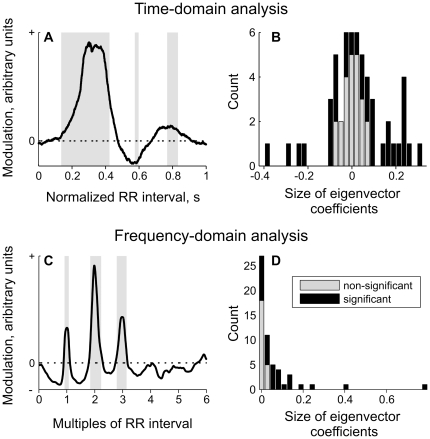
Principal component analysis (PCA) of 55 spontaneously active afferents in control (resting) conditions.Top panels display the first principal component of the time-domain analysis (explained variance = 48%), i.e. R-wave triggered discharge rate averages, extracting the modulation pattern common across afferents. Panel A shows the projection of the data with characteristic regions that are stable (p<0.01) across recordings depicted in gray. The time axis is normalized to the average RR-interval for each afferent before performing PCA. Panel B shows the histogram of the eigenvector coefficients representing the strength of this pattern in each afferent. Afferents with significant pulse wave modulation are depicted in black, non-significant afferents in grey. Lower panels display the first principal component of the frequency-domain analysis (explained variance = 43%), representing the common power spectrum across afferents (Panel C). The frequency axis is normalized to the average heart rate for each afferent before performing PCA. Panels D shows the histogram of the corresponding eigenvector coefficients.